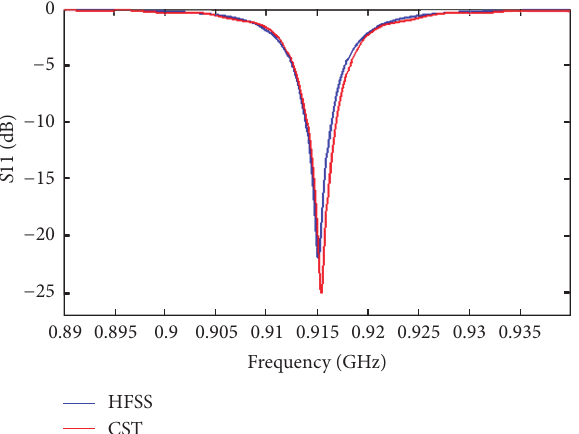
Figure 19: Return loss 𝑆11 of 3D spherical antenna (Table